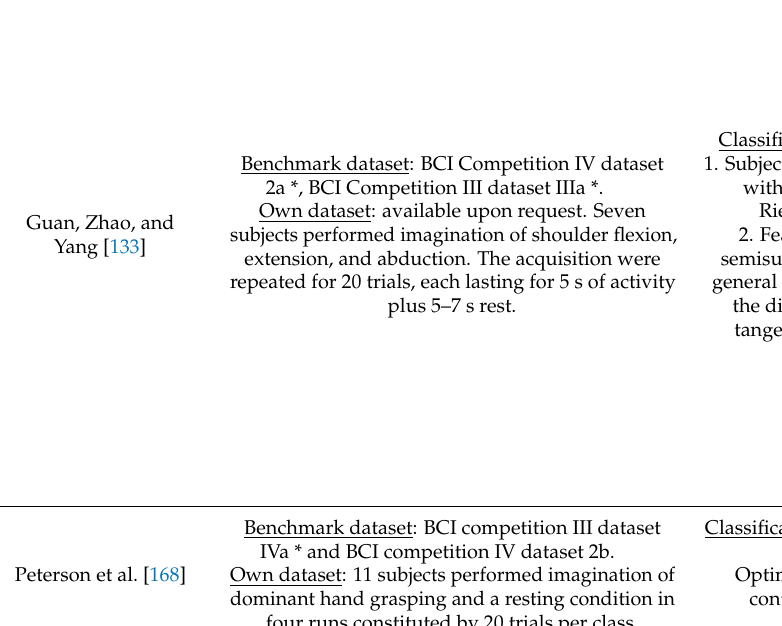
Classification task: binary (rest vs. dominant hand grasping). Optimal feature selection and classification contemporaneously performed through generalized sparse